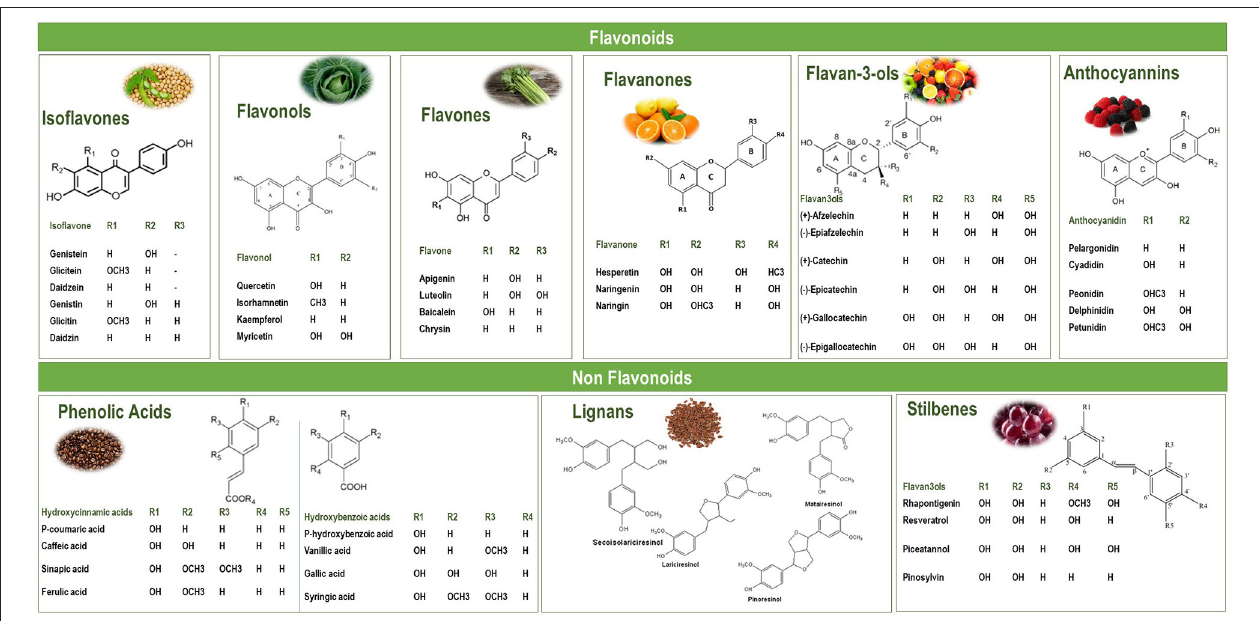
FIGURE 1 | Diversity in polyphenols structures and